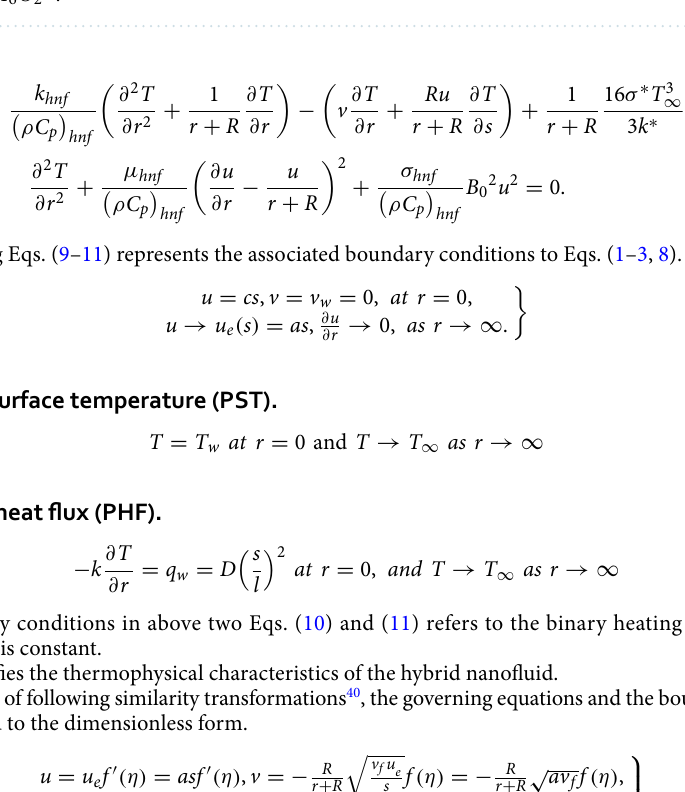
Table 1. Mathematical formulations of the thermophysical properties of C 2 H 6 O 2 − Al 2 O 3 and Cu − Al O C H O 2 3 / 2 6 2 39